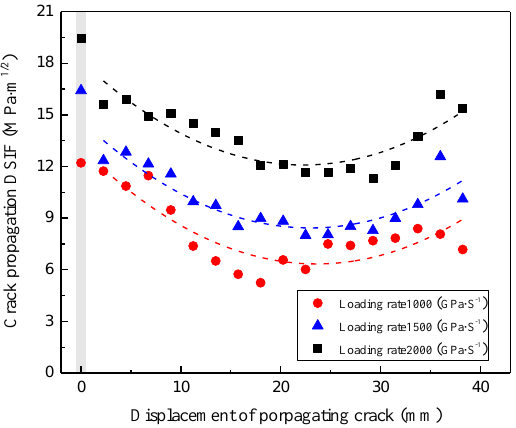
Figure 15. Crack propagation dynamic stress intensity factor in the complete